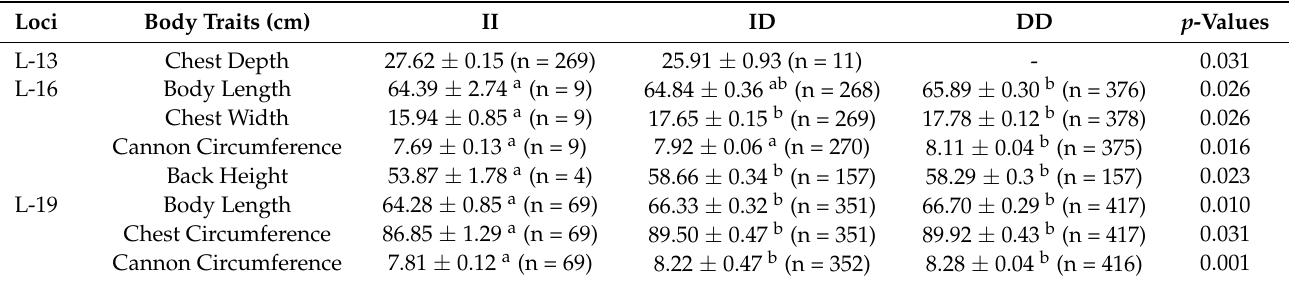
Table 3. Associations between InDel variants in CFAP43 gene and body traits of the Shaanbei white cashmere goats (Mean ± Standard error). Different letters indicate significant differences at p < 0.05.